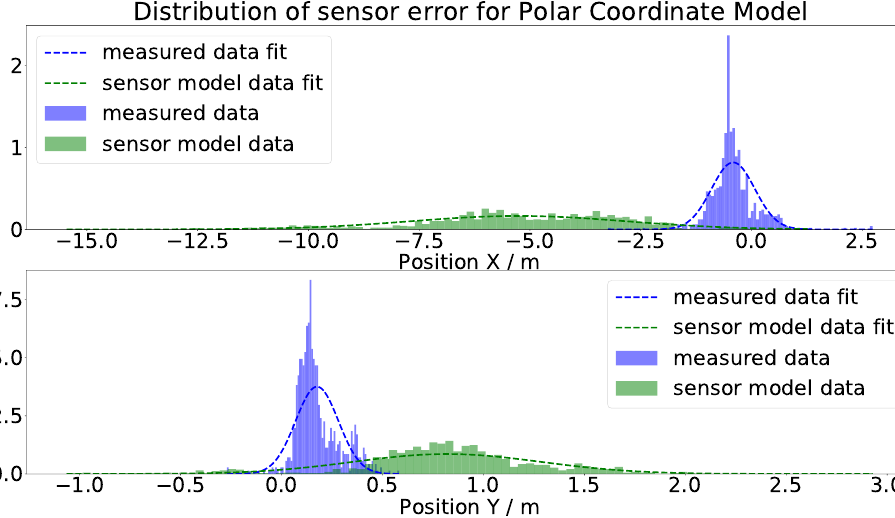
Figure 21. Histogram and Gaussian fit of the gap between the measured, respectively simulated, sensor data and the ground-truth values for the polar coordinate